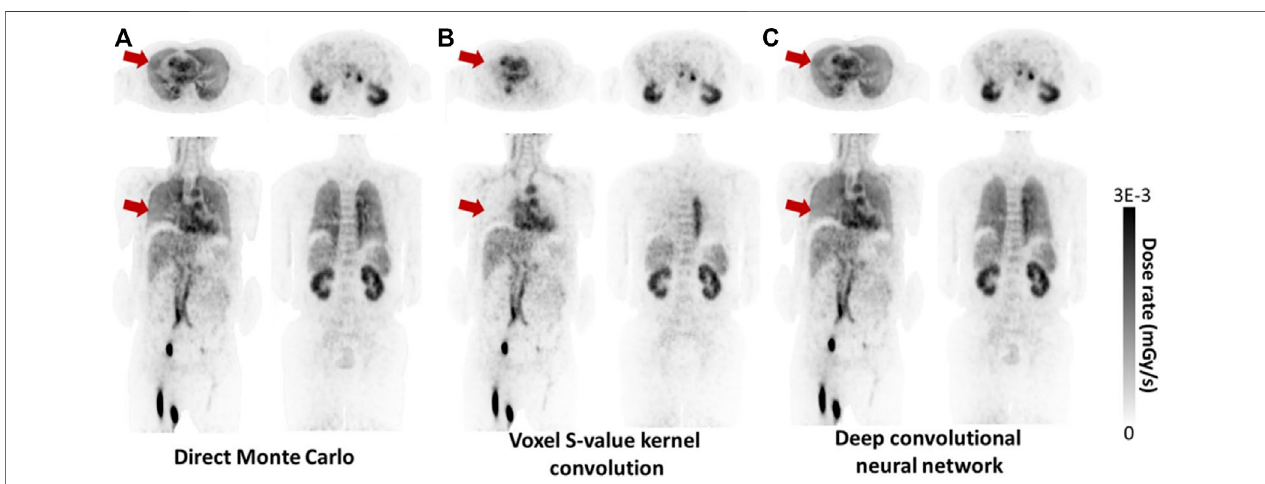
FIGURE 1 | Example of dose rate maps produced by direct MC simulation (considered ground truth), voxel S-value convolution and a deep convolutional neural network (CNN). The CNN approach generates dose rate maps similar to MC, and better agreement in certain areas such as lungs compared to VSV, as highlighted by the red arrows (With copyright permission -